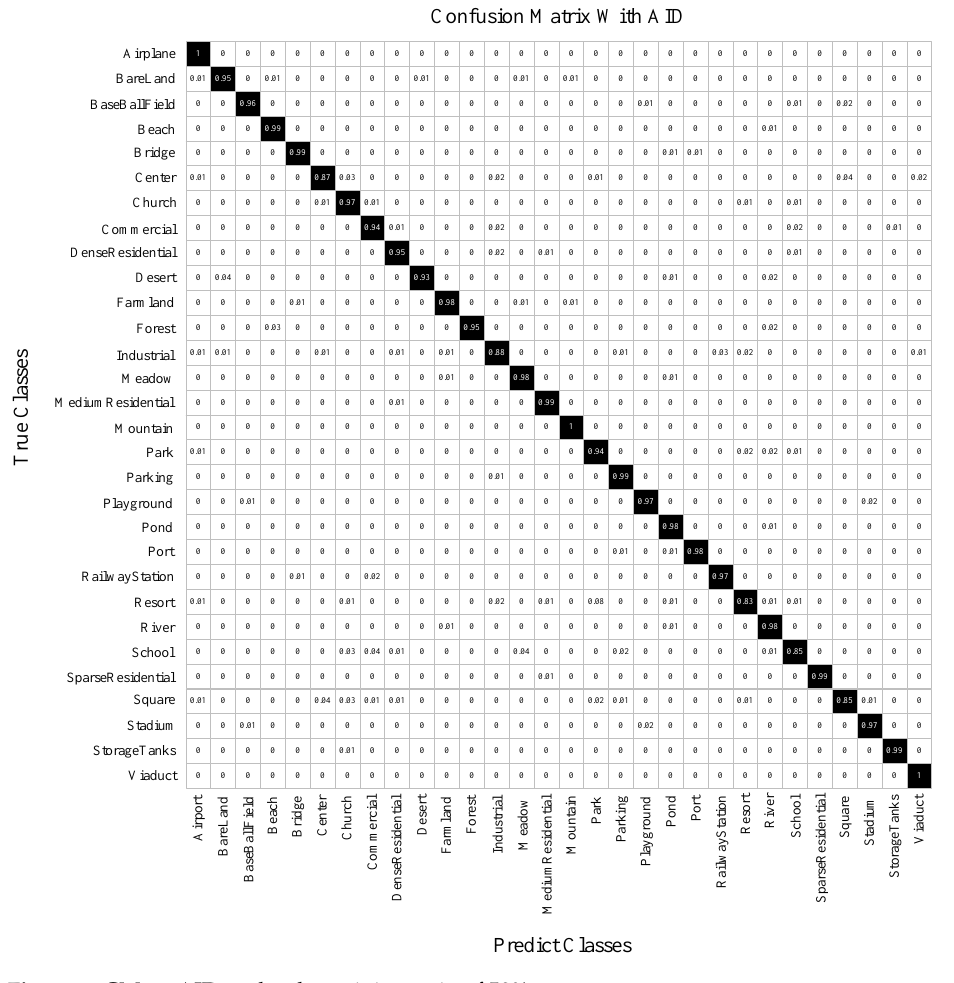
Figure 8. CM on AID under the training ratio of 50%.